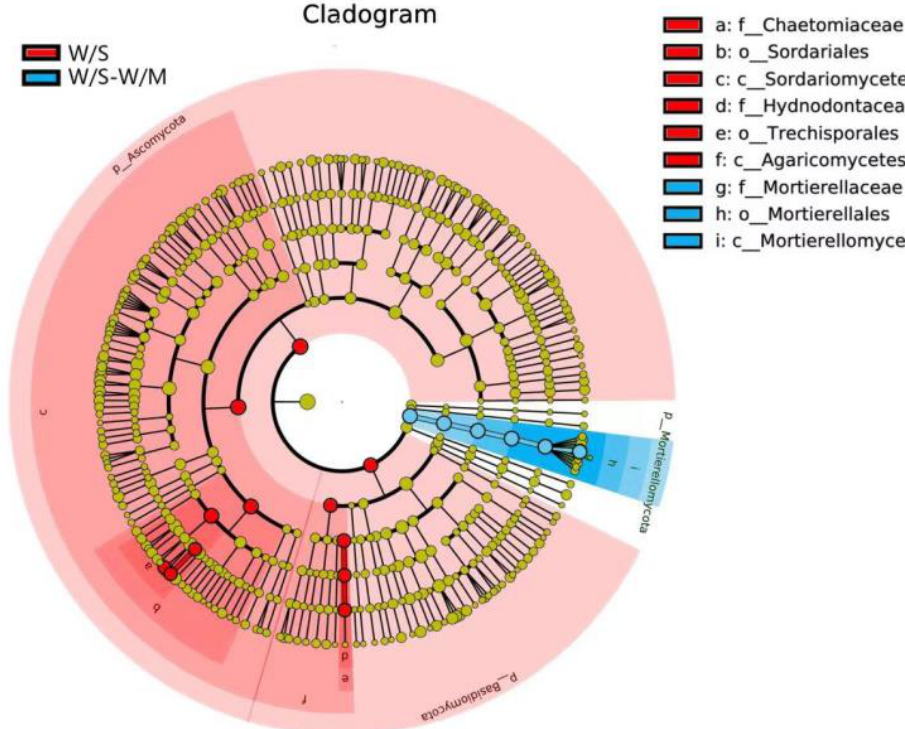
Figure 7. Taxonomic cladogram produced from the LEfSe analysis. The phylum, class, order, family, genus, and species levels are listed in order from inside to outside of the cladogram, and the labels for levels of the family and genus are abbreviated using a single letter. Red and blue showed taxa enriched in W/S and W/S-W/M, respectively, while the yellow circles represented the taxa without significant differences among the two cropping systems.